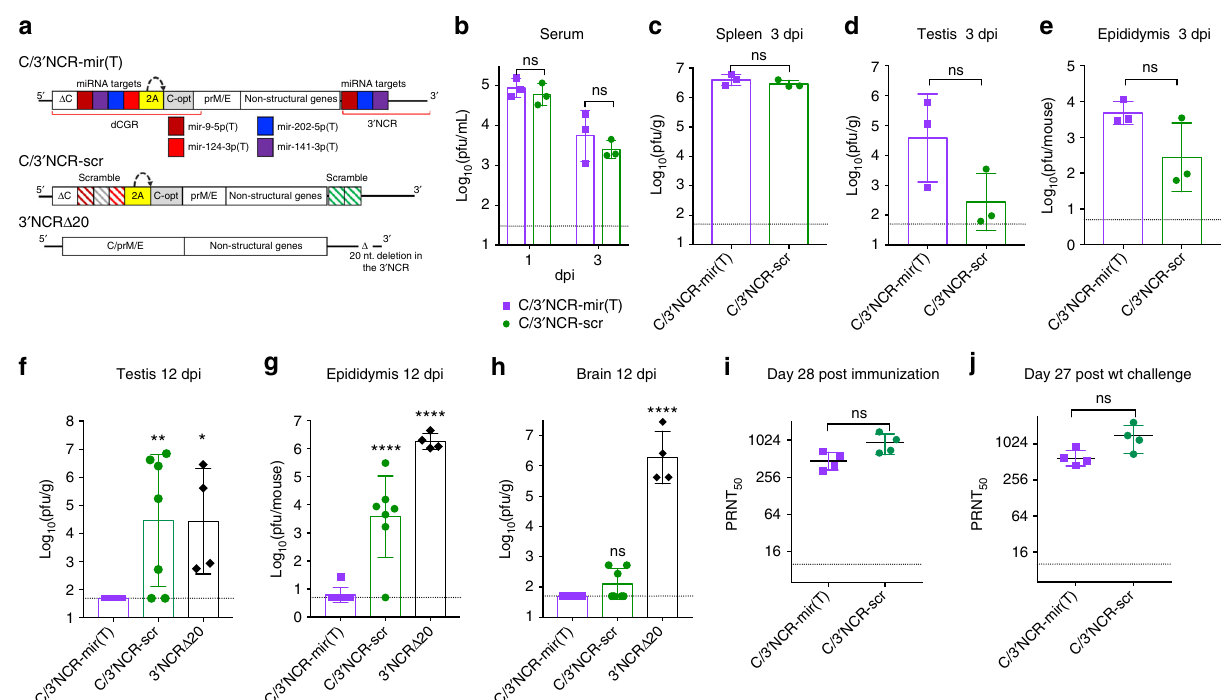
Fig. 5 Replication and immunogenicity of C/3 ’ NCR-mir(T) virus in adult AG129 mice. a Schematic representation of viral genomes used in the study. dCGR — duplicated capsid gene region; Δ C — truncated C gene; C-opt — a full-length copy of C gene containing synonymous mutations introduced in each AA codon (except AUG and UGG); colored boxes indicate miRNA targets for mir-9 – 5p (cherry), mir-141 – 3p (purple), mir-202 – 5p (blue), mir-124 – 3p (red); 2 A — autoprotease 2 A from foot-and-mouth disease virus (FMDV); the curved arrow indicates position of 2 A protease cleavage; striped cherry and red boxes indicate mutated targets for mir-9 – 5p and mir-124 – 3p, respectively; striped green box indicates scr sequence; striped gray box indicates random sequence of 21 nt. b – h mice were infected ip with 10 6 pfu of the indicated viruses. Mean virus titer ± SD (shown as error bars) in the serum at 1 and 3 dpi b , spleen at 3 dpi c , testis at 3 dpi d , and 12 dpi f , epididymis at 3 dpi e and 12 dpi g , and brain at 12 dpi h was determined by titration in Vero cells. The dashed lines indicate the limit of virus detection. Differences between viral titers in the mouse serum or organs at 1 or 3 dpi were compared using unpaired two-tailed t test (ns denotes not statistically signi fi cant; p > 0.05). Differences between viral titers in the organs at 12 dpi were compared using one-way ANOVA (ns